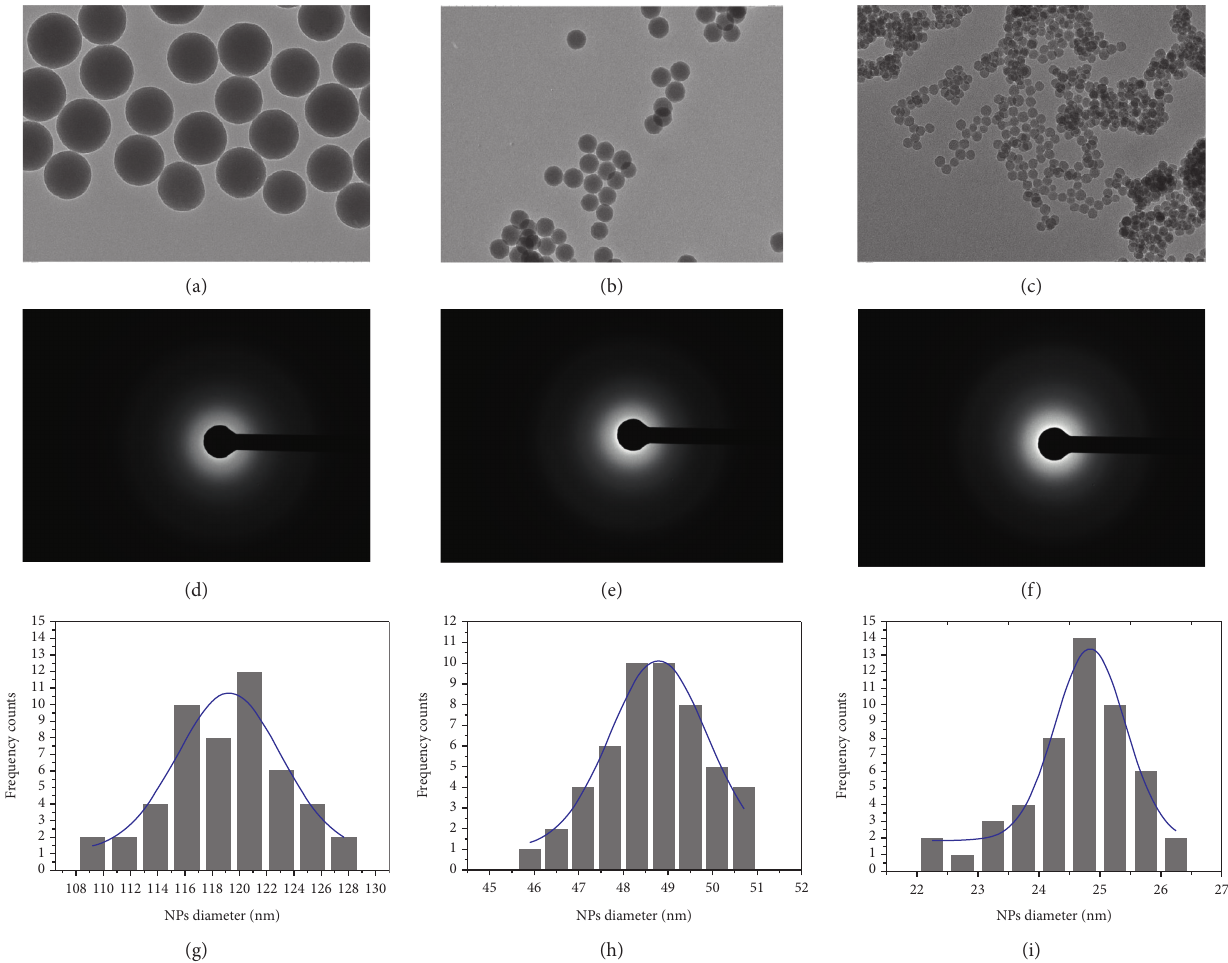
Figure 4: Representative TEM images of SiO 2 NPs 110nm (a), SiO 2 NPs 50nm(b), and SiO 2 NPs 25nm (c), and related diffraction figures (d–f). Statistical analysis with Gaussian fit (blue line) SiO 2 NPs 110nm(g), SiO 2 NPs 50nm(h), and SiO 2 NPs 25nm (i). The scale bar of (a), (b), and (c) is 200